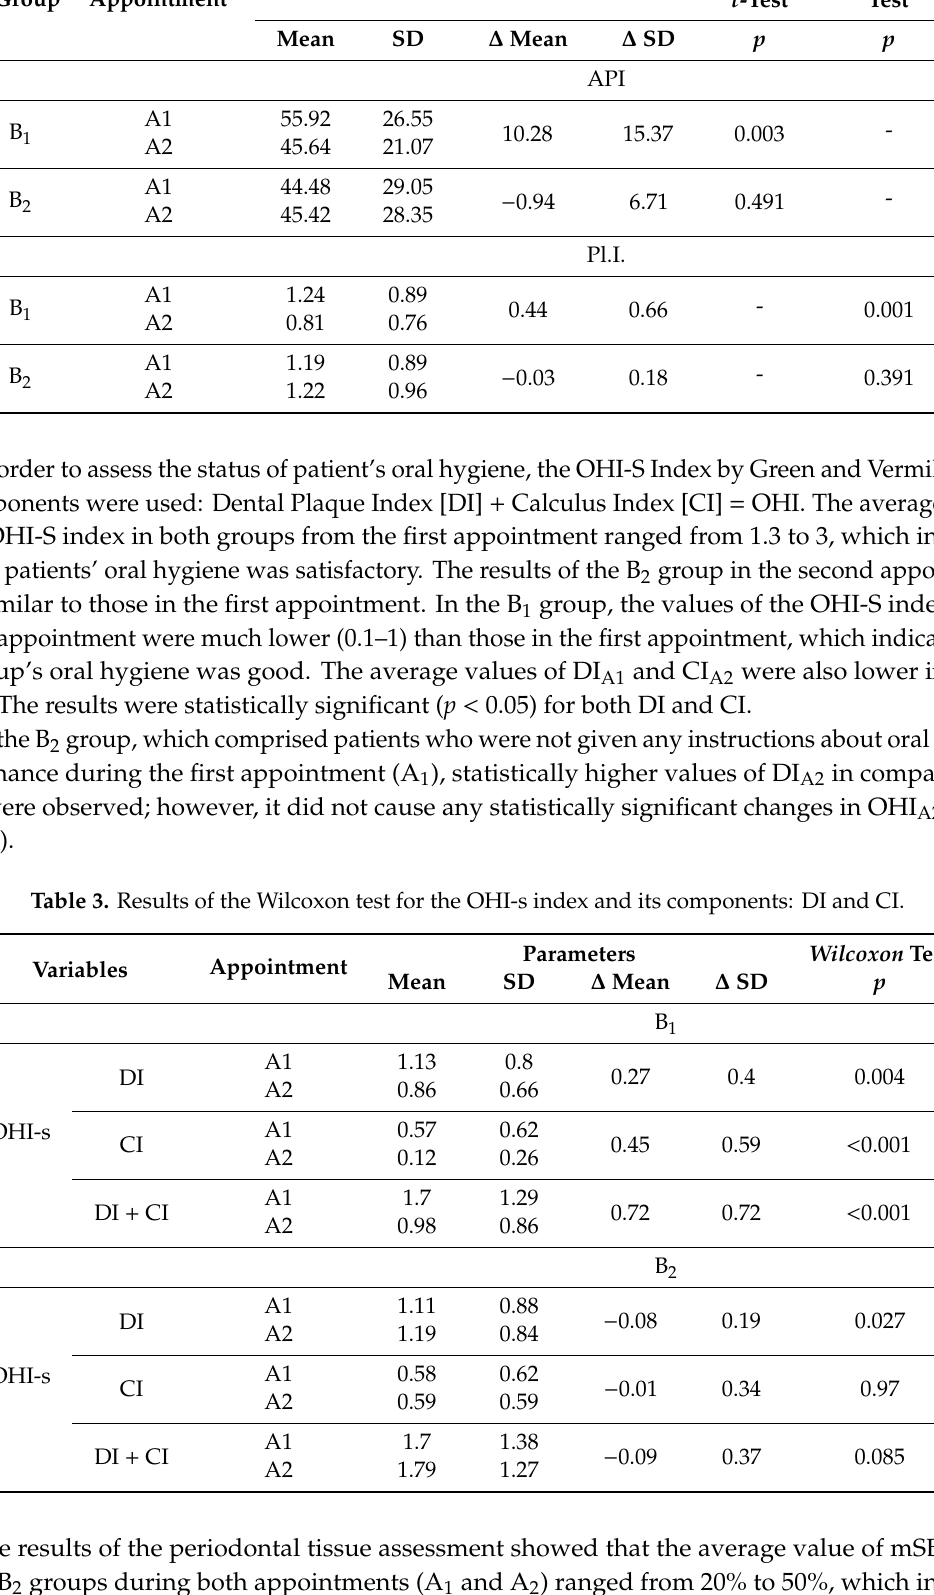
Table 2. Results of the Student’s t -test or Wilcoxon test for API and Pl.I. Group